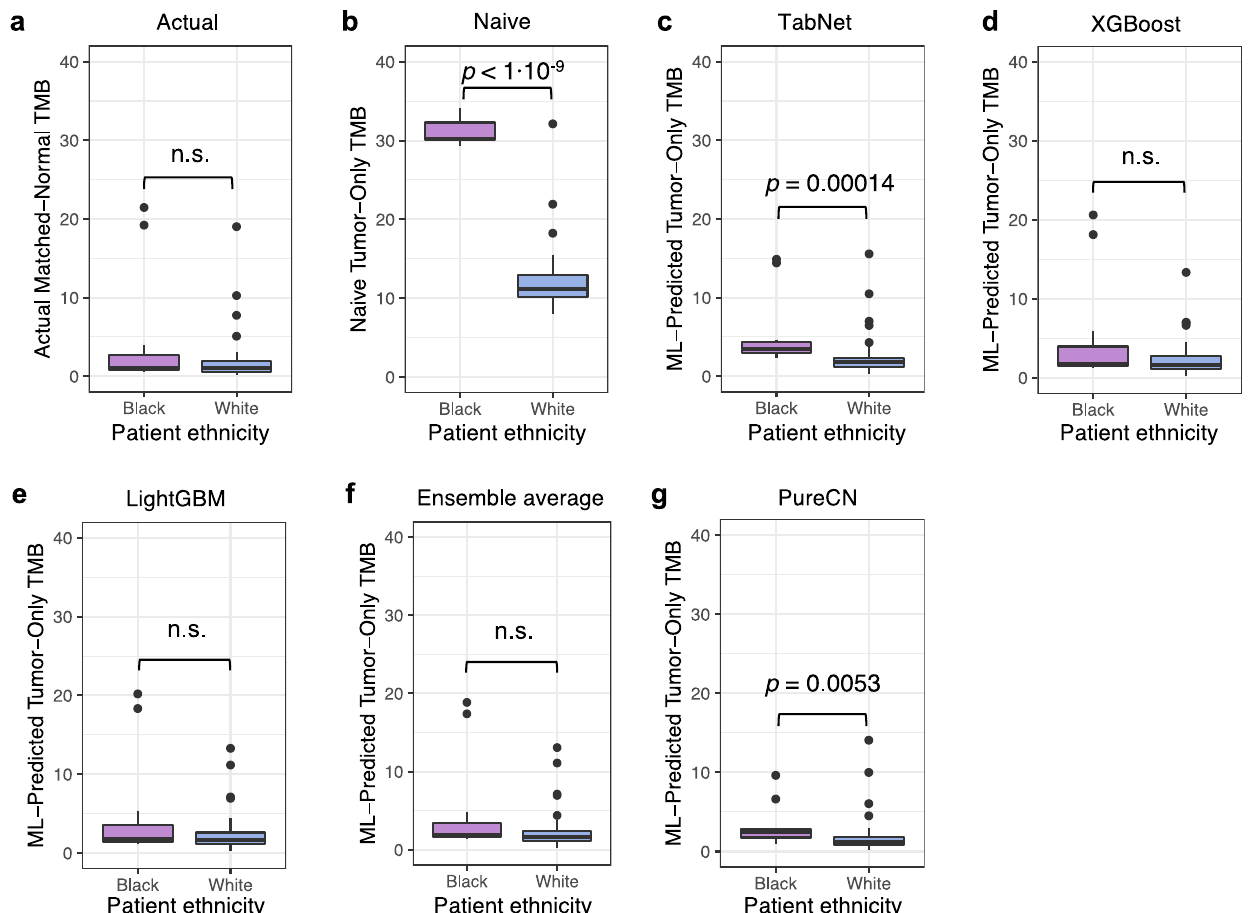
Fig. 4 Impact of racial bias in germline databases on tumor-mutational burden (TMB) estimates in tumor-only WES samples. Each panel displays patients from TCGA validation and holdout test sets, n = 12 Black and 55 white patients. a True TMB from matched-normal pipeline. b TMB estimates without matched-normal samples, using multiple germline population databases and a process-matched leave-one-out panel of normals (naive tumor-only method). c – g Corrected tumor-only TMB estimates using c TabNet, d XGBoost, e LightGBM, f ensemble average of tabular machine-learning (ML) models, and g PureCN. Boxplots depict the median (center line), fi rst and third quartiles (bounds of box), and maximum and minimum datapoints, excluding outliers (whiskers). Outliers are datapoints more extreme than the box boundaries by a factor of 1.5 times the inner quartile